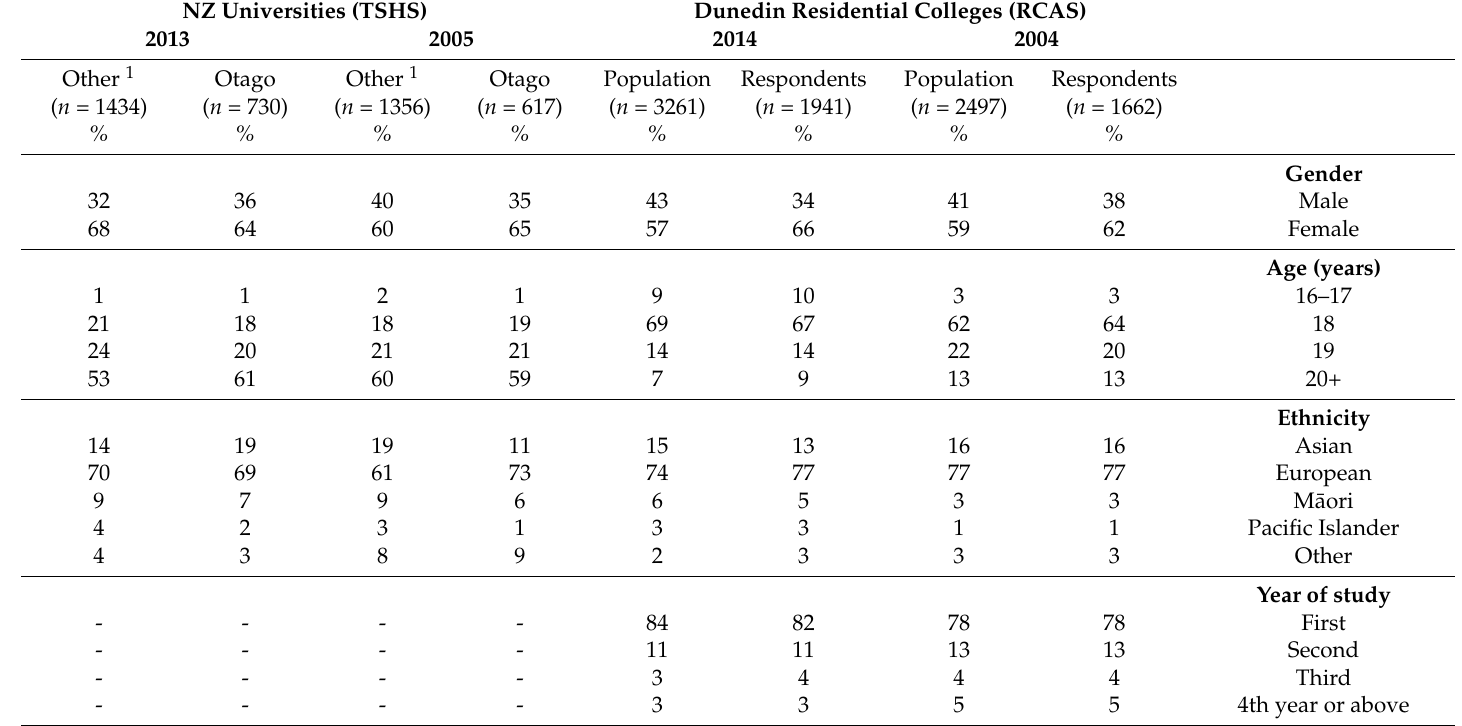
Table 1. Demographic characteristics of survey